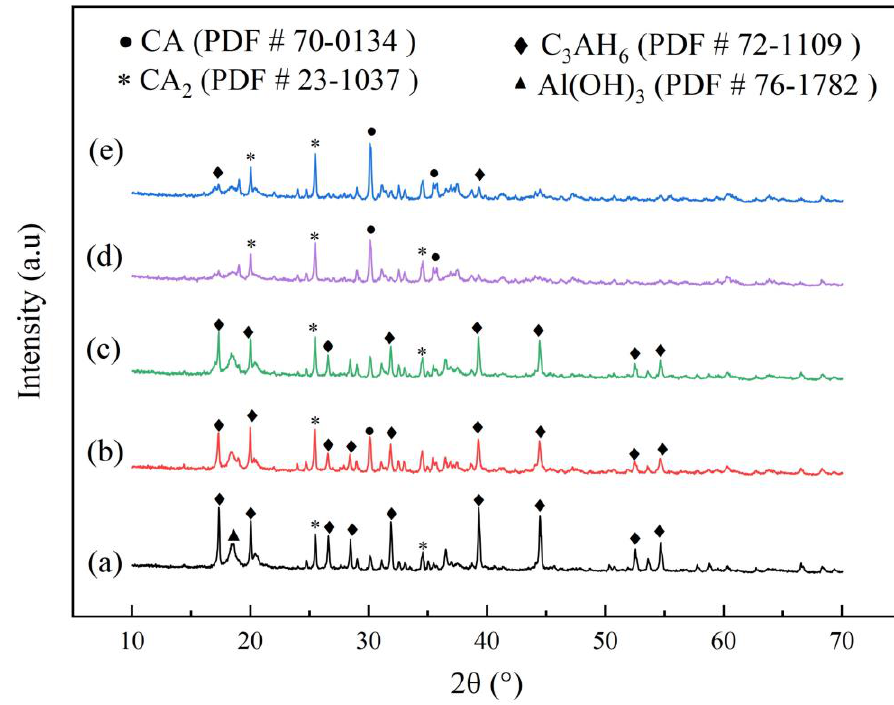
Figure 7. X − ray diffraction (XRD) patterns of PCAC after 1 d of hydration: (a) without STPP, (b) with 0.05% STPP, (c) with 0.1% STPP, (d) with 0.2% STPP, and (e) with 0.4% STPP.